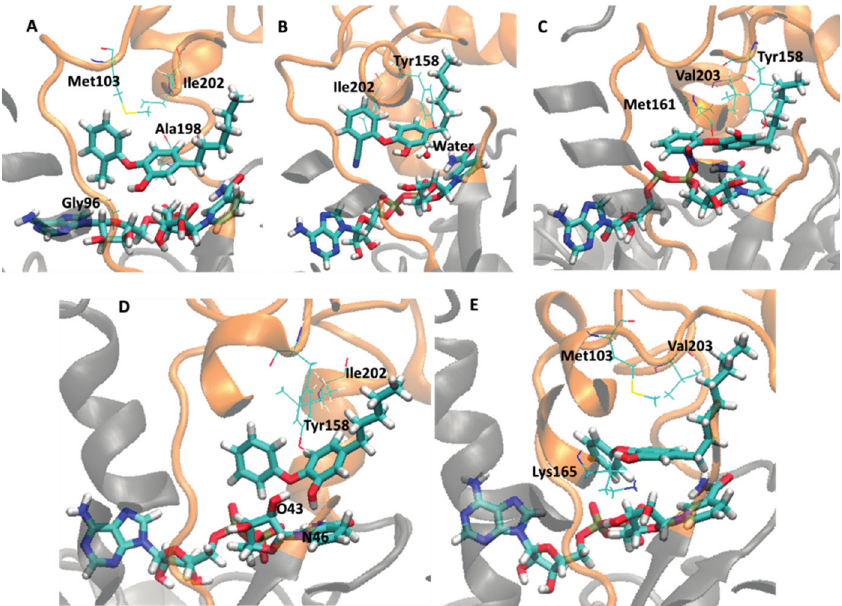
Figure 8. Close view of the InhA-NADH active site (orange) in complex with the alkyl diphenyl ethers inhibitors (TCU, JUS, 1TN, 5PP, and 8PS), showing important residues and water molecule. NADH and inhibitors are shown as stick models colored by element (carbon, cyan; hydrogen, white; nitrogen, blue; oxygen, red; sulfur, yellow). ( A ) InhA-NADH-TCU (2X23); ( B ) InhA-NADH-JUS (4OIM); ( C ) InhA-NADH-1TN (4OXY); ( D ) InhA-NADH-5PP (2B36); ( E ) InhA-NADH-8PS (2B37).